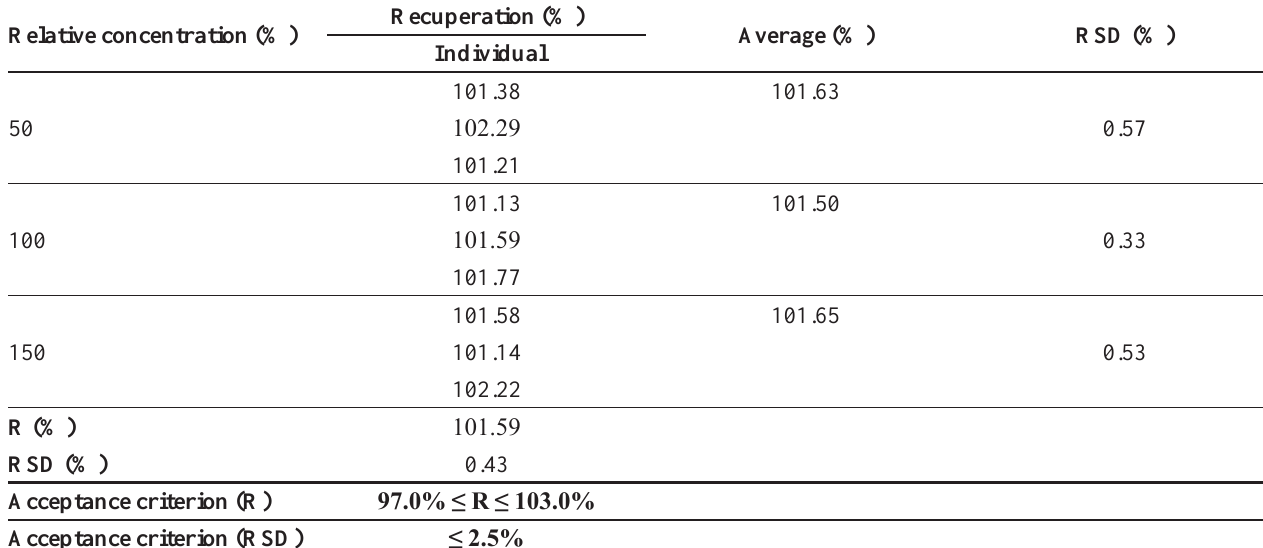
TABLE VII - Results of